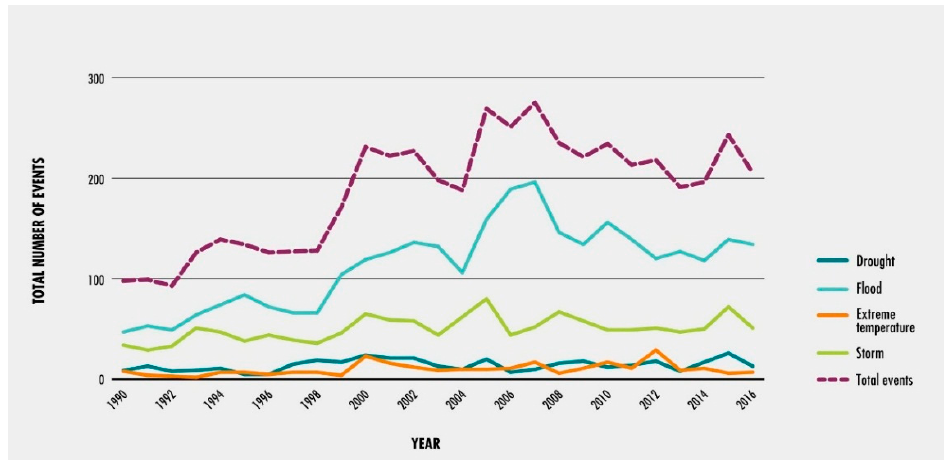
Figure 2. Increasing number of extreme climate-related events occurred during 1990–2016. Source: Food and Agriculture Organization (FAO) based on data from Emergency Events Database (EM-DAT) (https://www.emdat.be/) [24,25].